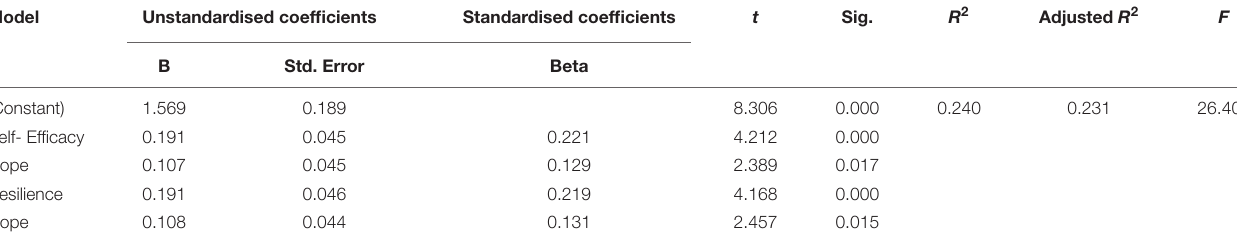
TABLE 8 | The influence of psychological capital (PC) variables on entrepreneurial intention (EI).